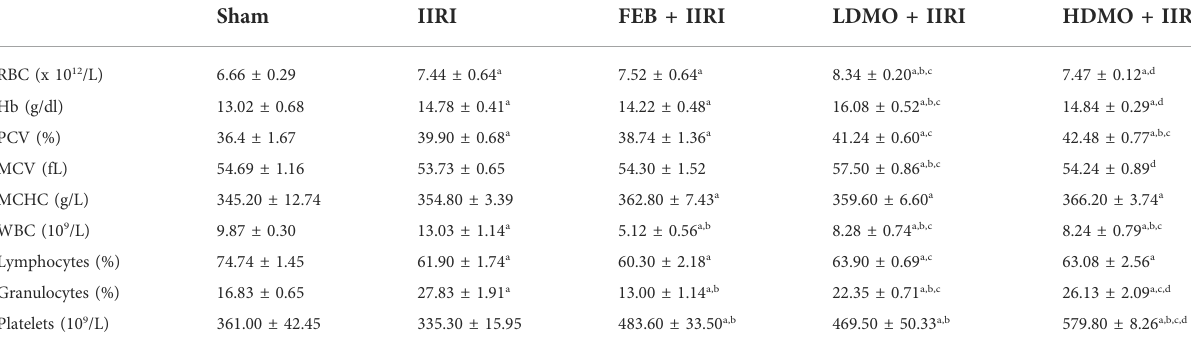
TABLE 1 Effect of intestinal ischaemia/reperfusion (I/R) and methanolic Moringa oleifera leaf extract on full blood count.